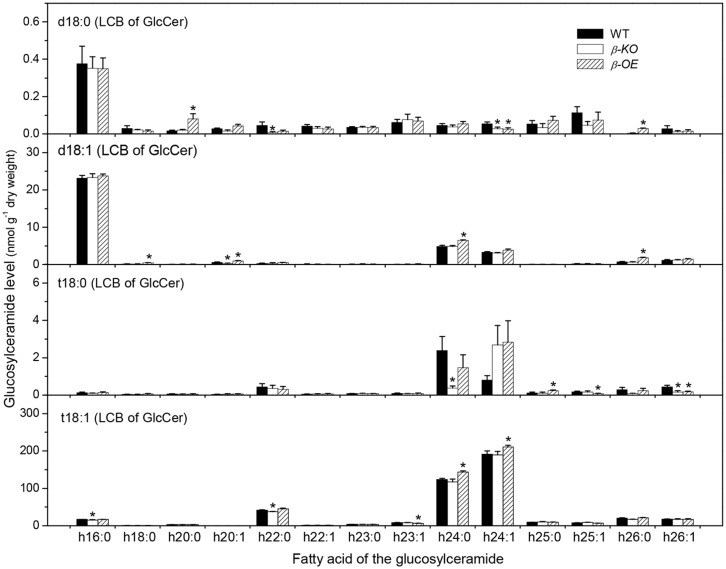
Levels of GlcCer species in pPLAIIIβ-knockout and overexpression plant leaves. β-KO, T-DNA knockout of pPLAIIIβ (Salk_057212). β-OE, overexpression mutant of pPLAIIIβ driven by cauliflower mosaic 35S promoter. Values are means ± SE (n = 5). *Significant difference at P < 0.05 compared with the WT, based on Student’s t-test.